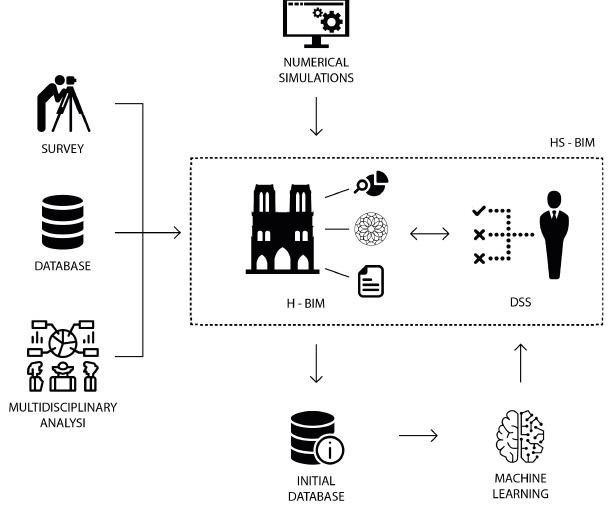
Figure 1. HS-BIM